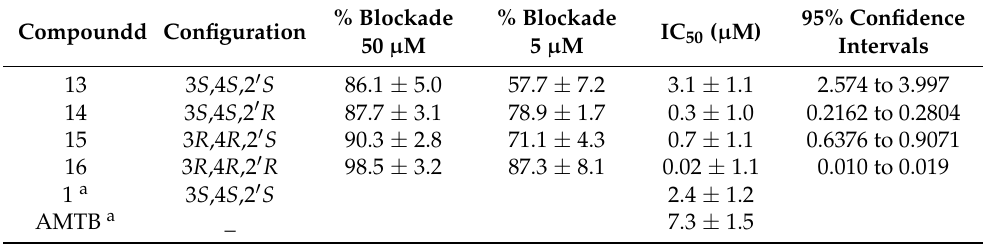
Table 1. Activity at TRPM8 channels of β –lactam derivatives (Ca 2+ influx assay). Compoundd